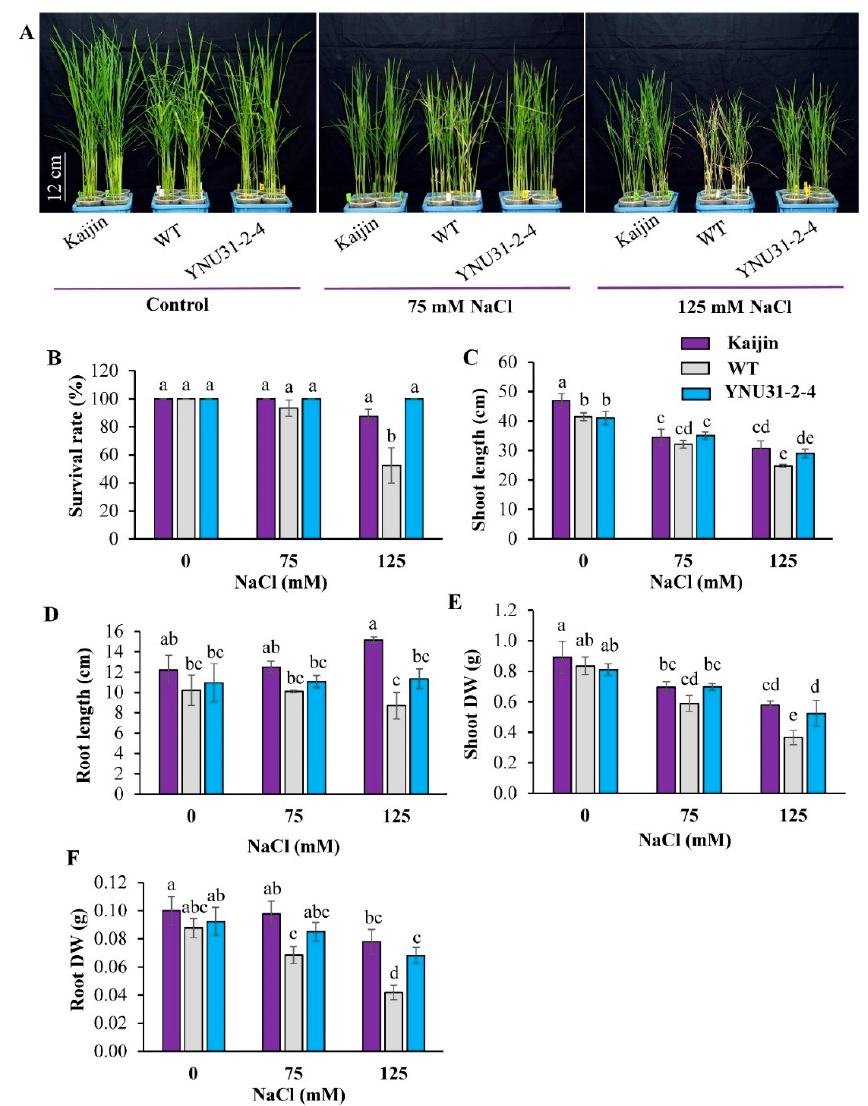
Figure 4. Salinity tolerance of BC 3 F 3 line “YNU31-2-4” at seedling stage. ( A ) Phenotypic comparison of “Kaijin”, WT, and “YNU31-2-4” seedlings grown in 0, 75, or 125 mM NaCl for two weeks. ( B ) Survival rates, ( C ) shoot length, ( D ) root length, ( E ) shoot dry weight, and ( F ) root dry weight of seedlings shown in A . Data in B – F are mean ± SD of four independent biological replicates; data in E and F are dry weight (DW) of 10 plants in each treatment. Bars labeled with the same letter are not statistically different (Tukey’s test, p < 0.05).